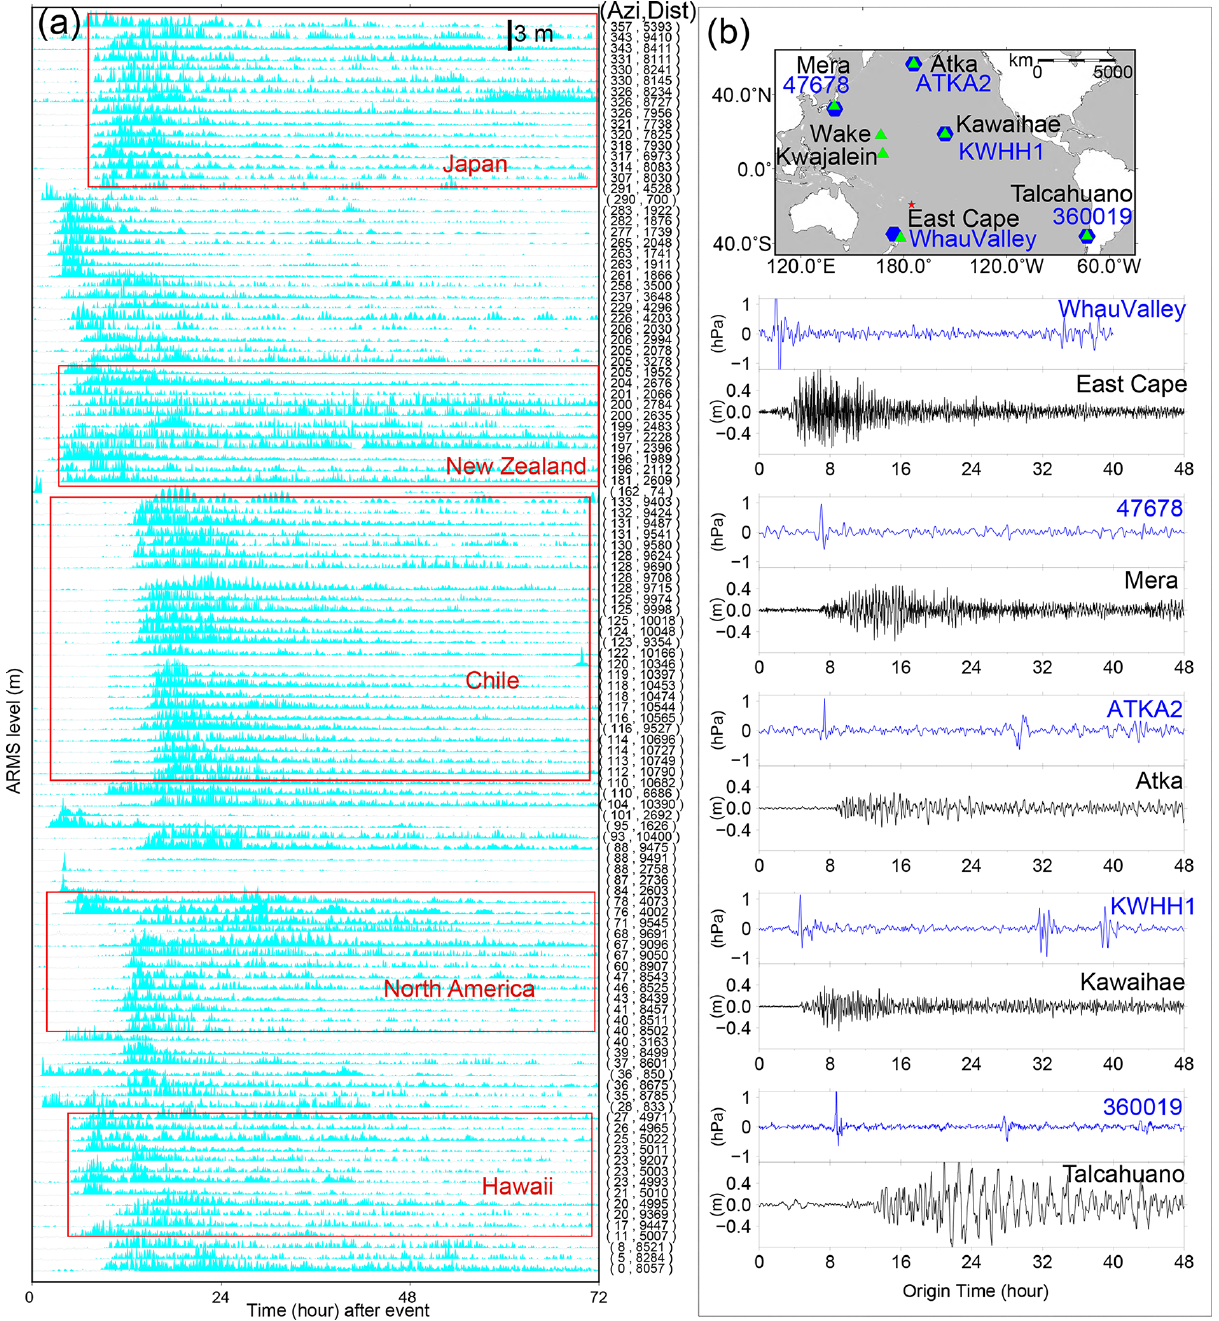
Figure 10. Tsunami duration. (a) Tsunami durations at 116 Pacific tide gauges through the ARMS level approach. (b) The location of barographs (blue hexagons) and nearby tide gauges (green triangles), as well as their